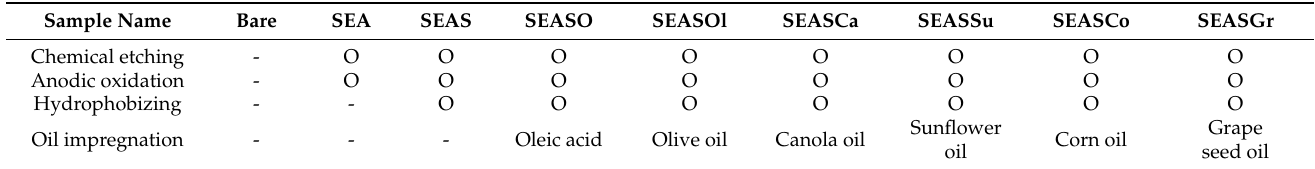
Table 1. Sample name regarding the treatments and oil